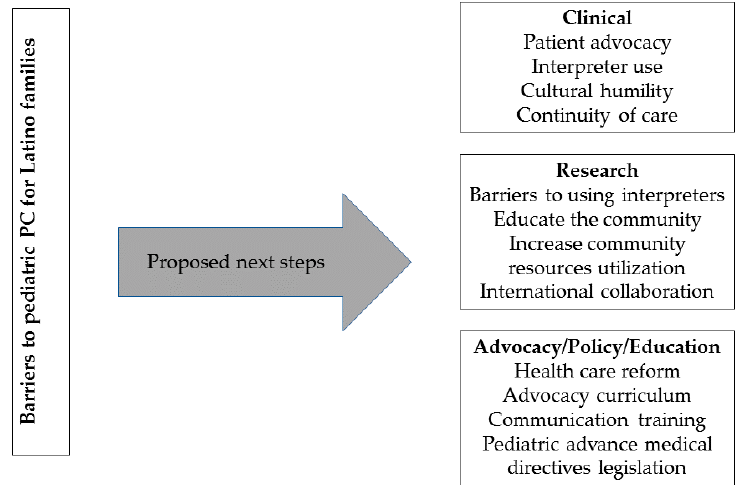
Figure 2. Proposed next steps to enhance the pediatric palliative care experience for Latino families.